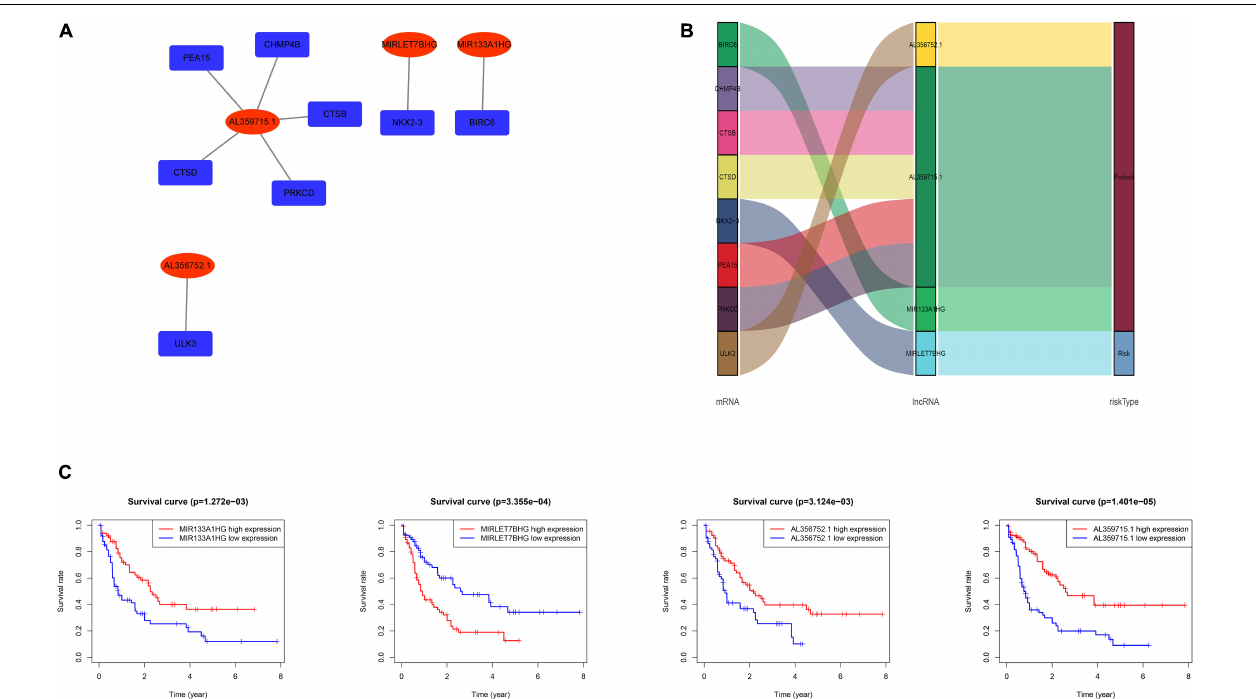
FIGURE 1 | (A) Network of the four lncRNAs with co-expressed autophagy-related genes in AML. The red nodes represent the lncRNAs and the deep blue nodes represent the autophagy-related genes. (B) The Sankey diagram shows the correlation between autophagy-related genes, autophagy-related lncRNAs and the risk type. The left box represents the autophagy-related genes, the middle box represents the lncRNA, and the right box represents the risk type (favorable/unfavorable). (C) Kaplan–Meier survival curves for the four lncRNAs in AML.